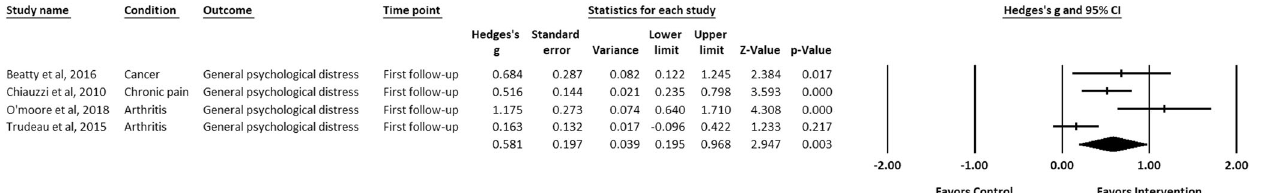
Fig. 7 Forest plot for effect sizes of IM-CBT on general psychological distress at fi rst